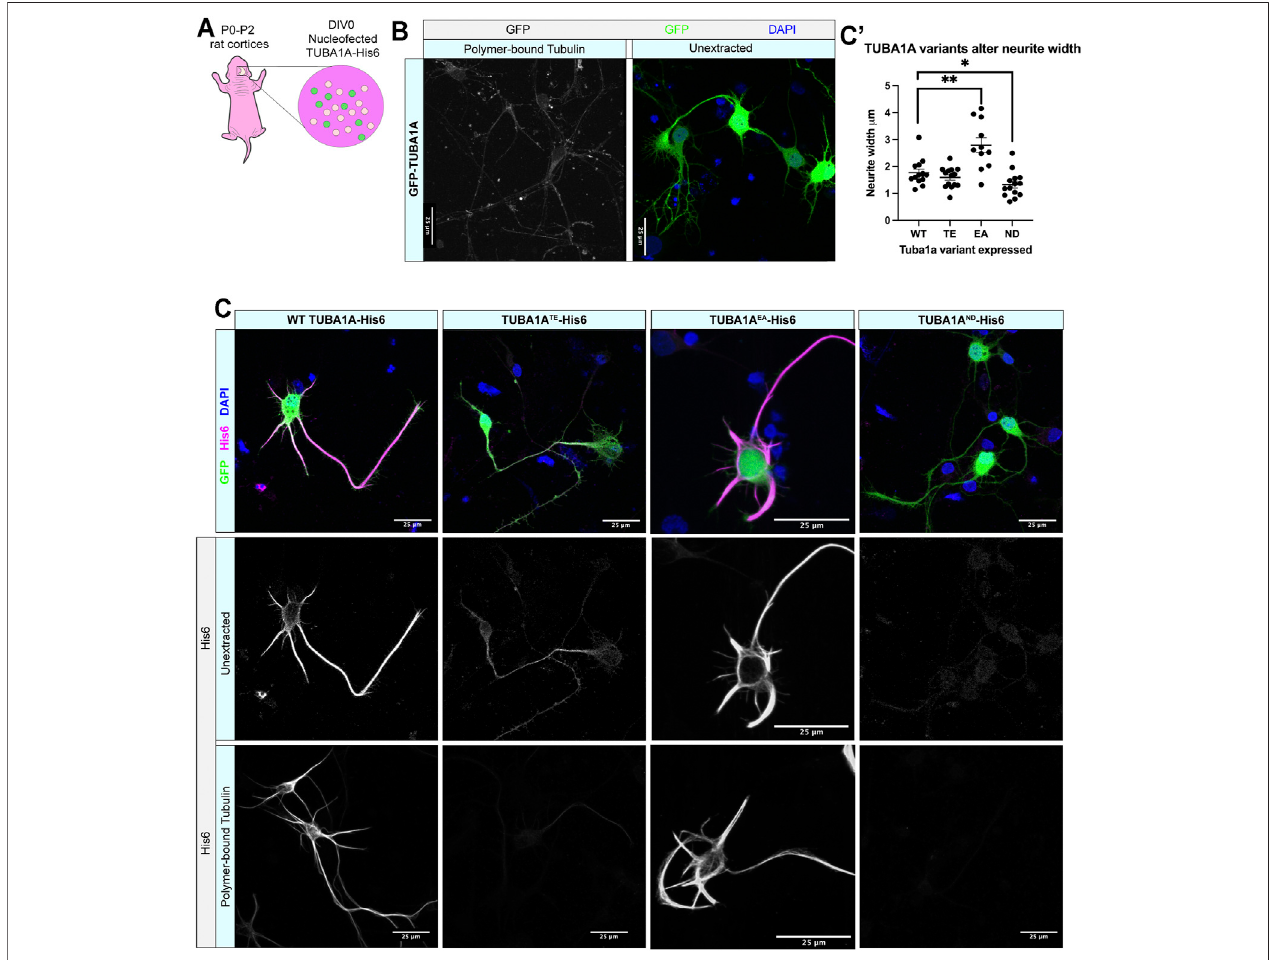
FIGURE2| TUBA1A ND α -tubulindoesnotincorporate intoneuronalmicrotubulepolymers. (A) Schematicofcorticalneuronisolation and transfection. (B) Cortical rat neurons at DIV 2 transfected with TUBA1A -GFP. Left panel shows neurons with soluble tubulin dimers extracted, showing only GFP-labeled TUBA1A that is incorporatedintomicrotubulepolymer.Rightpanelshowsneuronswithintracellular environmentintact(unextracted),containingsolubletubulindimers andpolymerized microtubules transfected to express a TUBA1A-GFP fusion protein. (C) Rat cortical neurons at DIV 2 transfected with wild-type (WT) TUBA1A -His6 (far left), TUBA1A TE -His6polymerization-incompetentmutantasanegativecontrol(middleleft), TUBA1A EA stabilizingmutantasapositivecontrol(middleright), TUBA1A ND -His6 (far right). Top panels show composite image containing membrane-bound GFP (green) for con fi rmation of transfection, α -His6 (Magenta) and DAPI (blue) immunolabeling.MiddlepanelsshowunextractedandbottompanelsshowdifferentDIV2neuronsaftertubulinhasbeenextractedtorevealonlypolymer-boundtubulin, labeled with α -His6 antibodies to visualize ectopic TUBA1A -His6 proteins. Scale bar is 25 μ m. (C 9 ) A Scatter plot shows that neurons expressing His6-Tuba1aEA have signi fi cantly wider neurites than neurons expressing His6-Tuba1aWT and neurons expressing His6-Tuba1aND have neurites that are signi fi cantly thinner than neurons expressing His6-Tuba1aWT * p < 0.05, ** p <